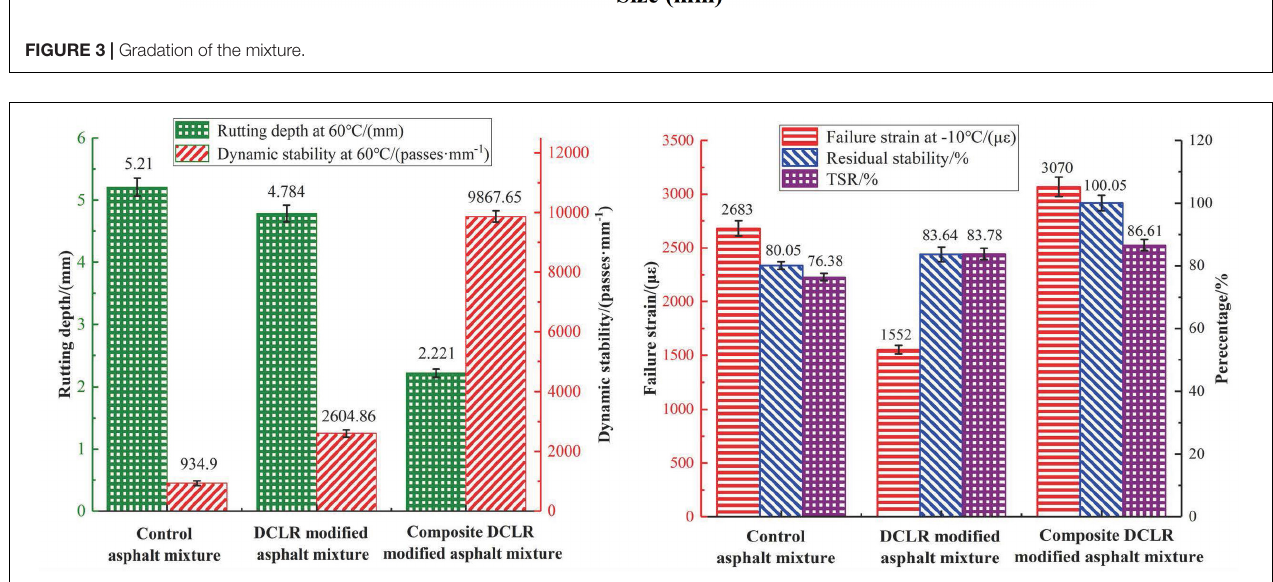
FIGURE 4 | Performances of three asphalt